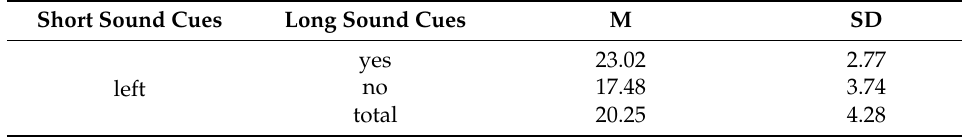
Table 8. Results of optimization rate.